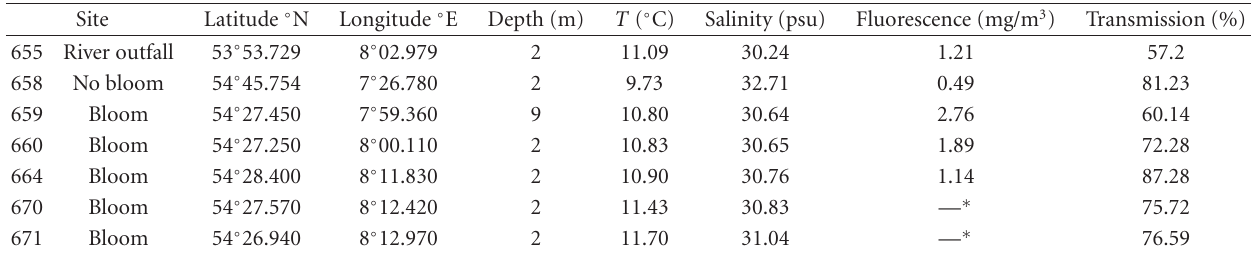
Table 2: Parameters of sampling sites analyzed in this study.